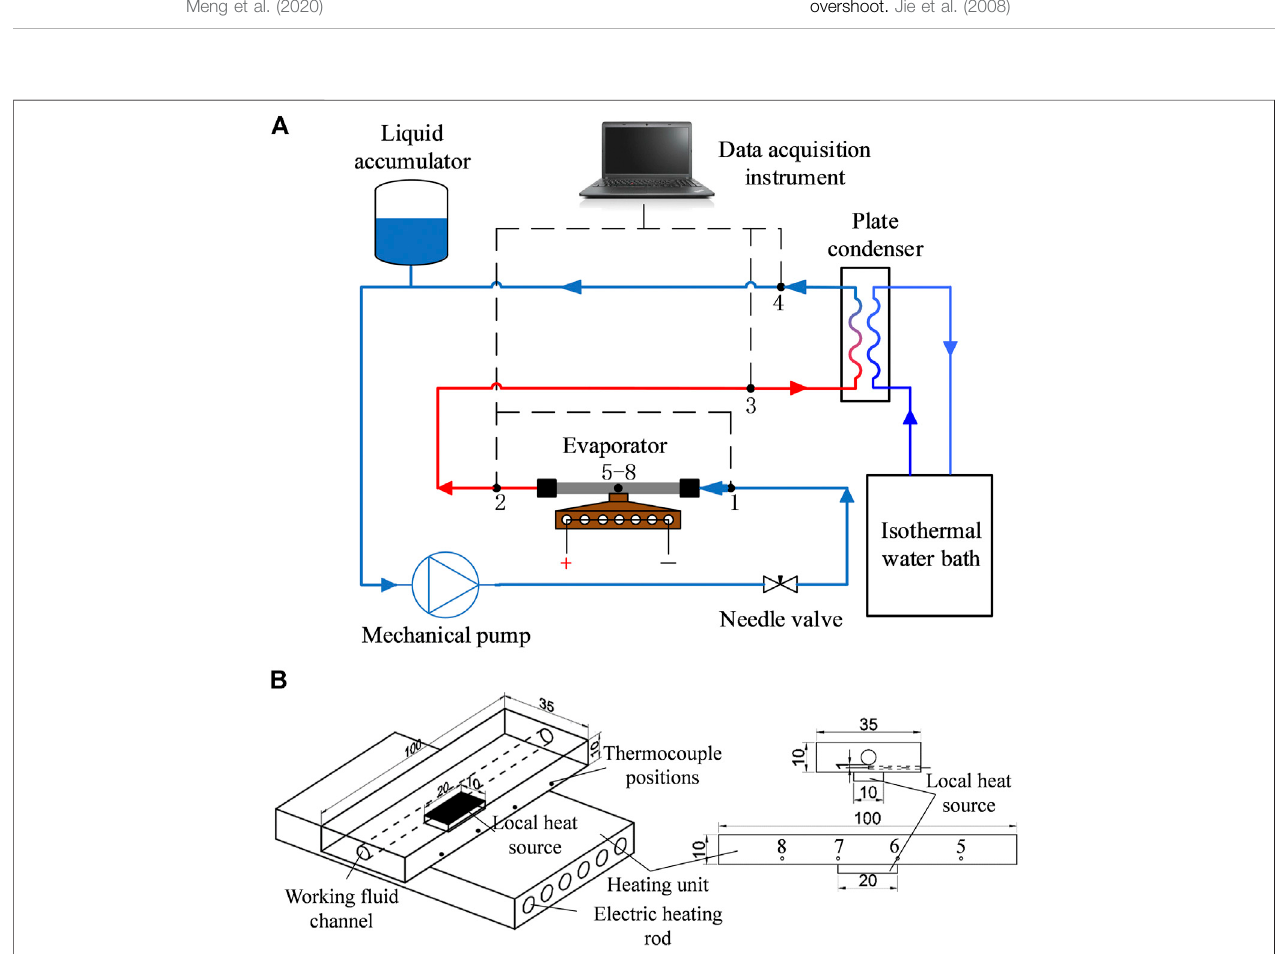
FIGURE 1 | Experimental setup: (A) schematic and (B) dimensions of the heating unit and thermocouple positions.